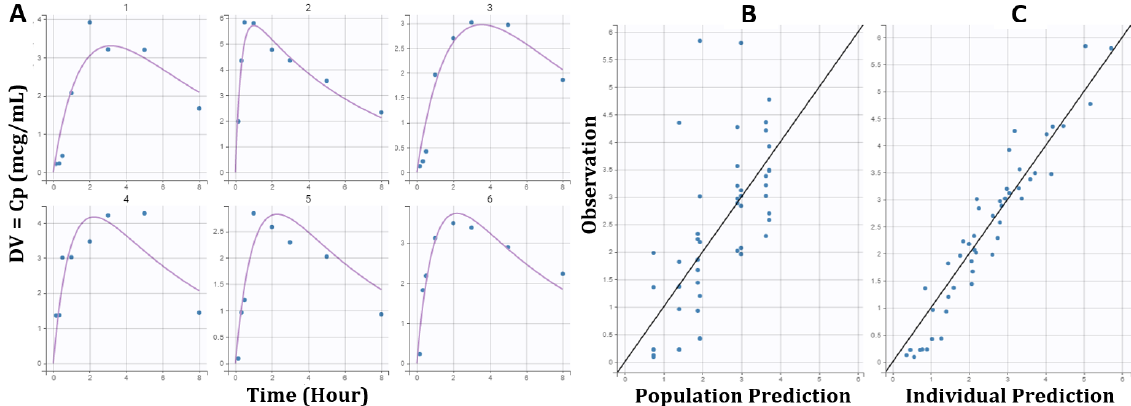
Figure 3. The goodness of fit of the one-compartment open model of levofloxacin after peroral administration, i.e., individual data fitting analyses (panel A); observation versus population prediction analysis (panel B), and observation versus individual prediction analysis (panel C).